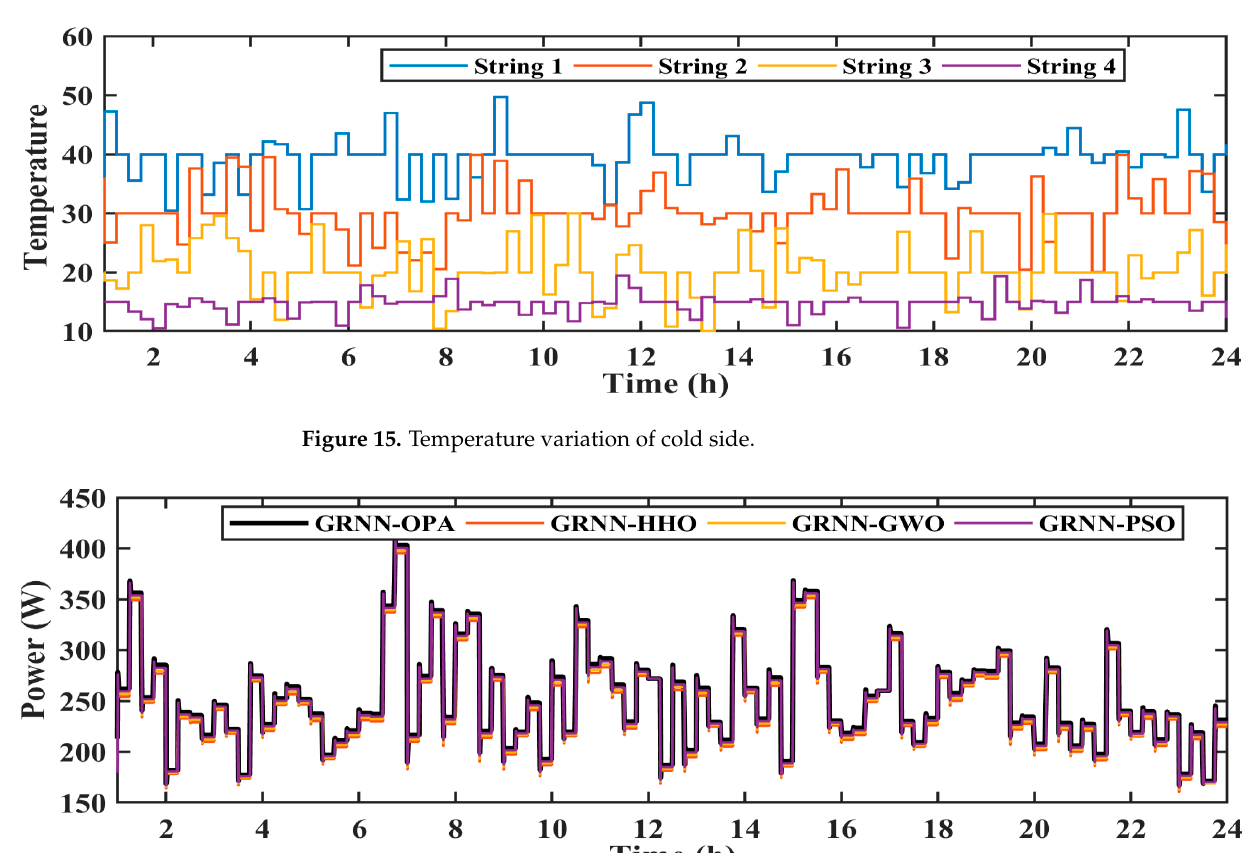
Figure 14. Temperature variation of hot side.